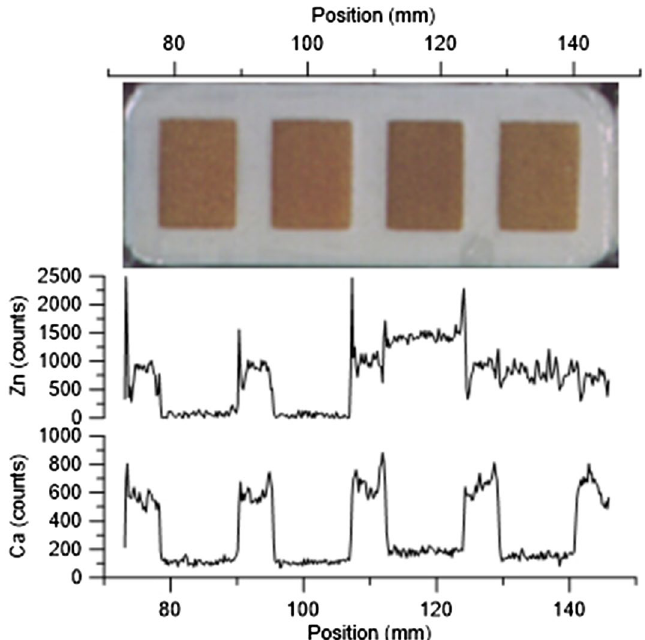
Figure 3. Optical image and XRF scan results for Ca and Zn in one of the three sample carrier prototypes (ASA). The Ca counts show strongly elevated levels over the compartment walls, compared to the ion-exchange resin. The Zn counts show, as expected, higher values in the resins that were immersed in the test solution, but also distinct peaks at the boundaries of the the sample carrier compartment walls. The carrier was loaded with (left to right) untreated resin, resin exposed to deionized water, resin exposed to 10 ppm solution, resin exposed to < 10 ppm